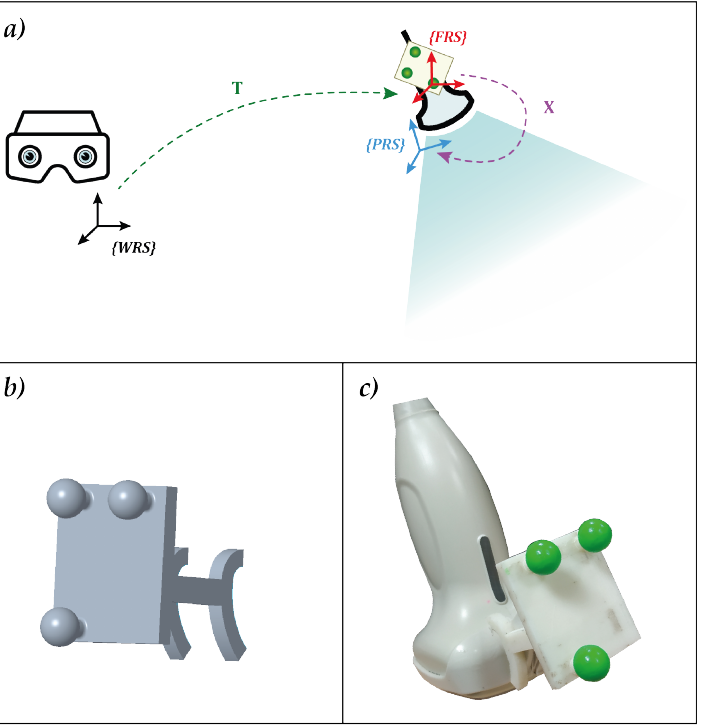
Figure 3. ( a ) the elements involved in the calibration with the associated reference systems and their relative transformation matrices. ( b ) the optical frame designed for calibration. The three spherical markers were dyed in fluorescent green to improve the robustness of the RGB tracking ( c